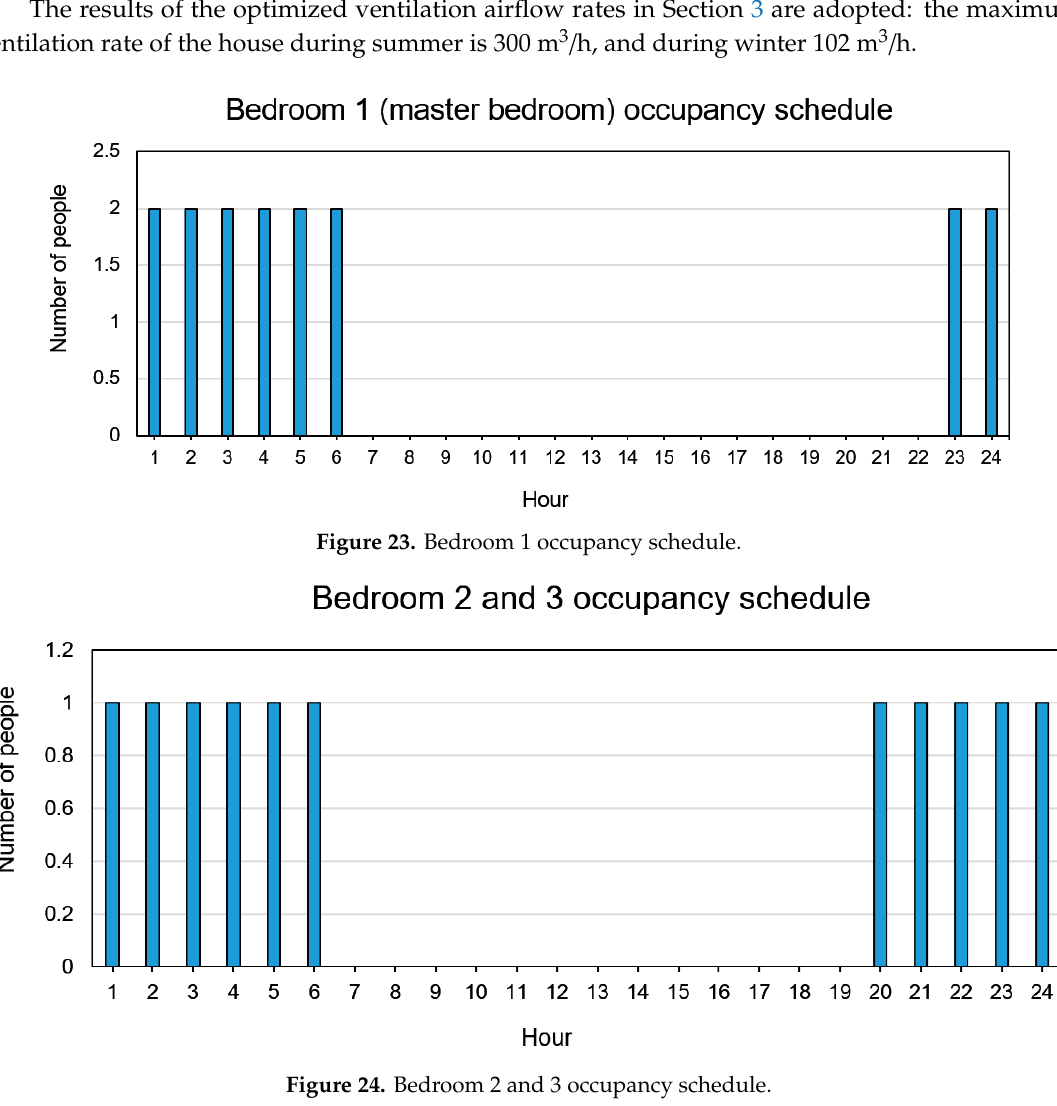
Figure 24. Bedroom 2 and 3 occupancy schedule.